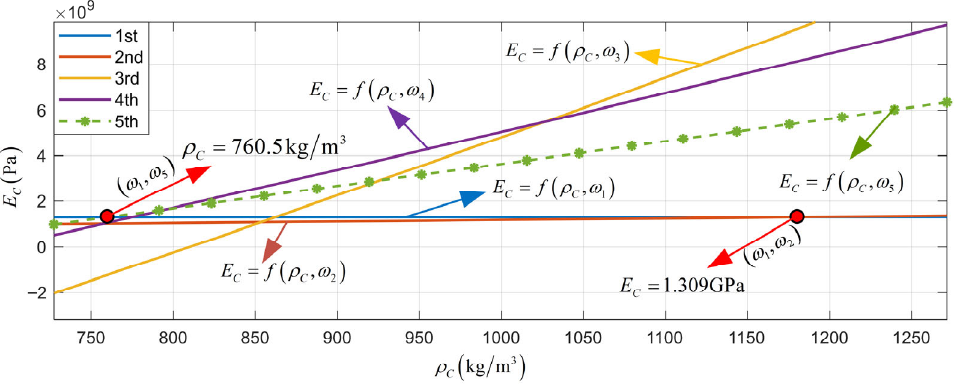
E ‐  curves of the first five order natural frequencies and the recommended fre ‐ Figure 10. Figure 10. E C - ρ C curves of the first five order natural frequencies and the recommended frequency C C quency pairs to calculate the Young’s modulus and density values of the adsorbate. pairs to calculate the Young’s modulus and density values of the